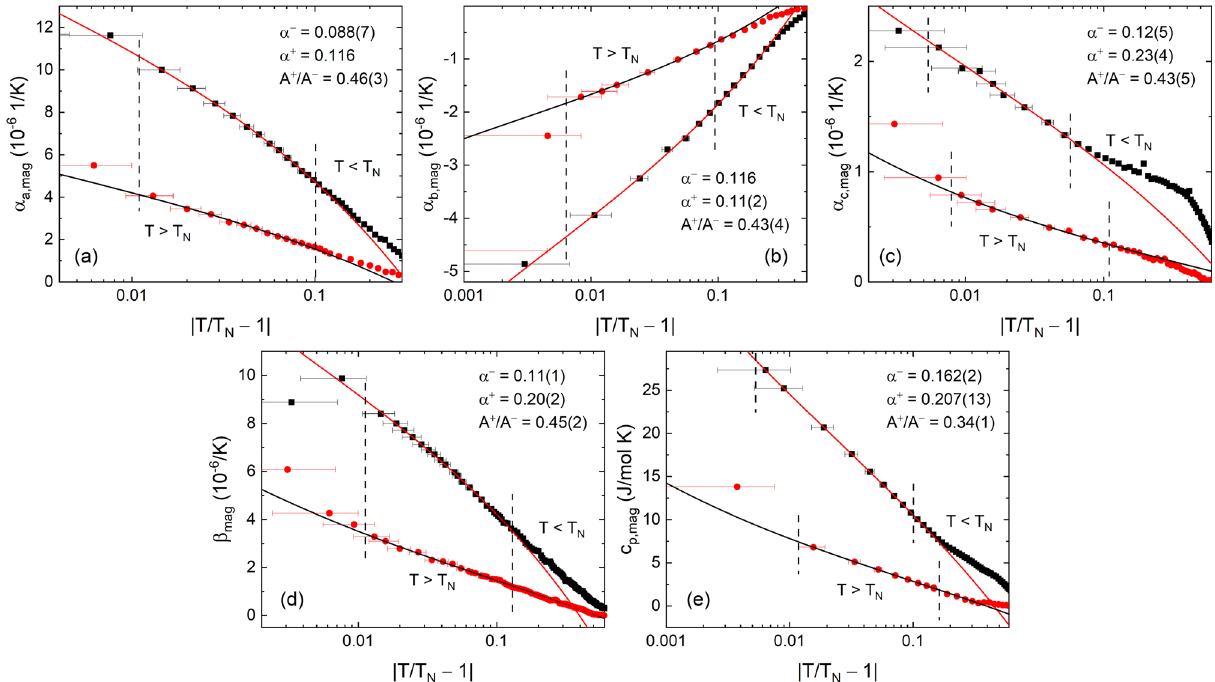
Figure 7. Critical scaling analysis near T N . Semi-logarithmic plots of the magnetic contributions to ( a – c ) the thermal expansion coefficients α i ,mag , i = a , b , c , ( d ) the magnetic volume expansion coefficient β mag and ( e ) the specific heat versus reduced temperature | t | = | T / T N − 1 | , for T N = 26.4 K. Black squares (red circles) mark data for T < T N ( T > T N ). Red and black solid lines are fits to the data according to Eq. (5), vertical dashed lines indicate the fitting window. Values for α ± with no error given were fixed for the